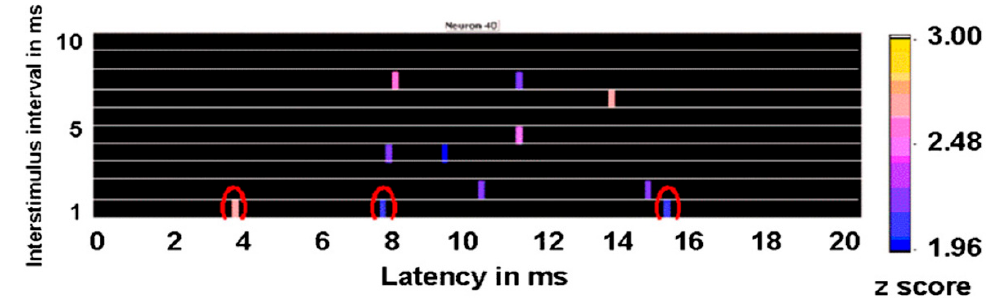
Figure 15. Results from paired-pulse experiments for a neuron recorded in the motor cortex of a nonhuman primate. Each row represents changes in the probability of a neuronal discharge from baseline for each interstimulus interval of the paired-pulse stimuli. Colored bars represent any change that has a z score greater than 1.96 compared to baseline. The horizontal axis represents the latency of the resonance effect after the second or test pulse of the pair.